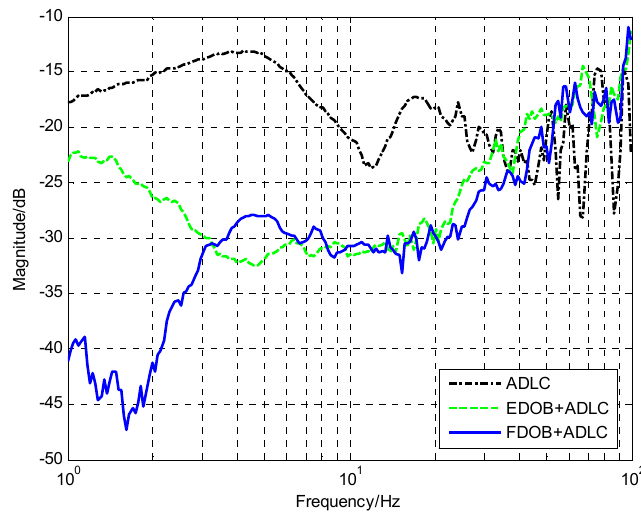
Figure 10. The improvement of DS brought by EDOB and FDOB.